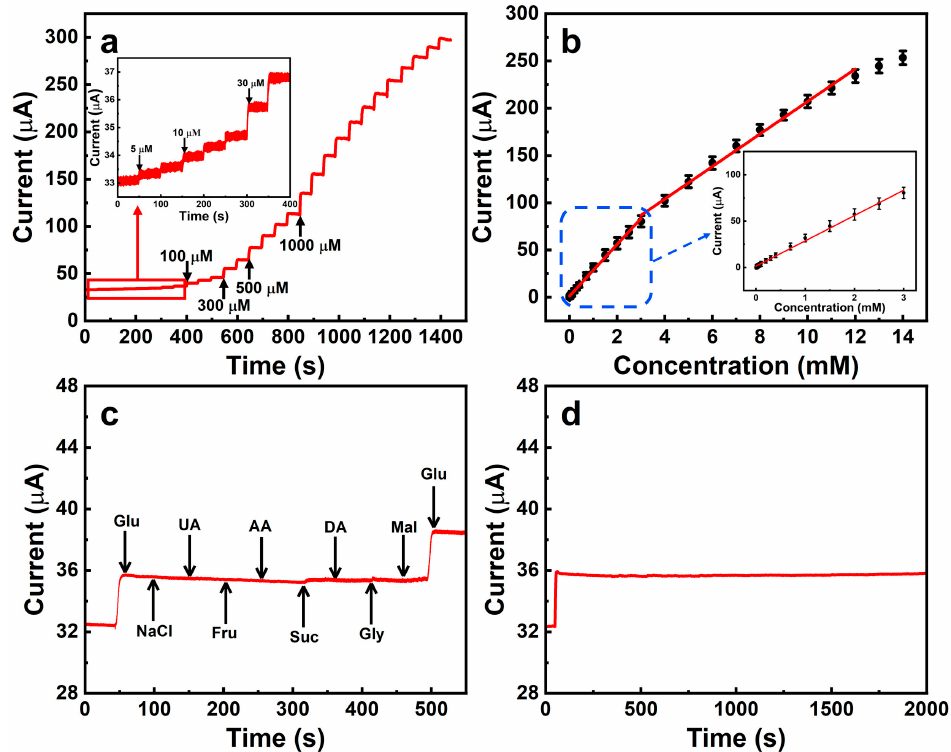
Figure 6. ( a ) Amperometric response of Mn 3 O 4 /NiO/CNFs electrode for different concentrations of glucose (inset is current response at low concentrations); ( b ) calibration curves corresponding to ( a ); ( c ) current response of Mn 3 O 4 /NiO/CNFs electrode to 100 μ M glucose and different interferences; ( d ) the stability test of Mn 3 O 4 /NiO/CNFs electrode during the 2000 s. All the above experiments were conducted under optimal parameters. Table 1. Performance comparison of the proposed Mn 3 O 4 /NiO/CNFs/GCE with other glucose sen- sors.